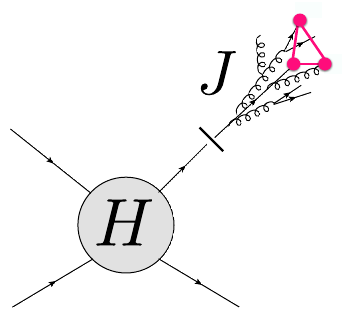
Figure 2. A schematic of the factorization for the triple correlation function in the collinear limit. In the collinear limit, we can factorize on a single partonic state produced by the hard function, H . The measurement is then imposed on the jet function, which can be computed perturbatively for di(cid:11)erent partonic